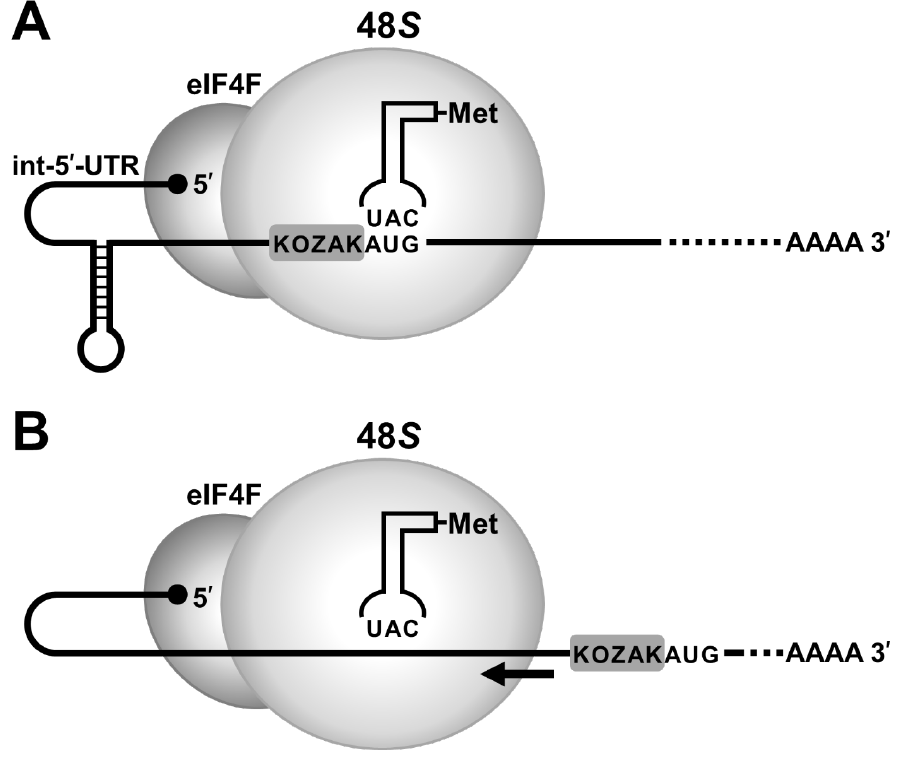
Figure 1: Diagram of (A) proposed new normal eukaryote scanning-less and (B) canonical scanning translation initiation model. A. 48 S , human 48S translational initiation ribosome [9], is position at the cognate translation initiation site flanked by a Kozak (KOZAK) motif with Met-tRNA at the P site and the int-5ʹ-UTR intervening between 5ʹ-m 7 G (●) (bound to eukaryote initiation factor eIF4F complex) and i proximal 48 S boundary is located in the aqueous environment. B. 48 S is tethered to 5ʹ-m 7 G (●) and stochastic movement brings the cognate translation initiation site into 48 S . The diagram is based on that depicted in [11]. Although the mRNA is depicted as a linear molecule, in vivo the 3ʹ polyA terminus is attached to 5ʹ-m 7 G terminus via interaction of a polyA binding protein with eIF4F